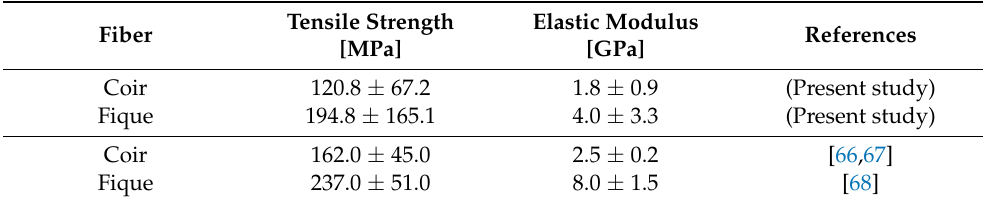
Table 4. Mechanical properties for coir and fique fibers. Present work compared with the previous